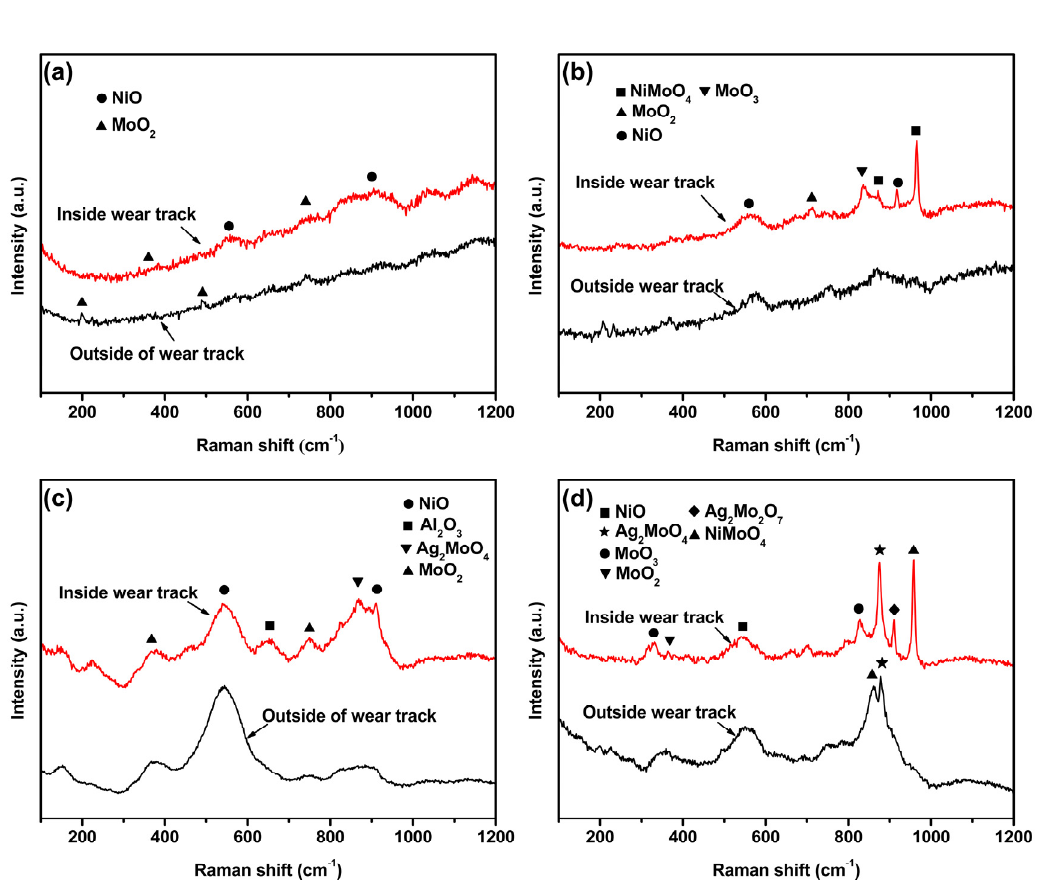
Figure 7. Raman spectra inside and outside the wear scar at 800 °C: ( a ) N, ( b ) NM, ( c ) NA, and ( d ) NMA composites.